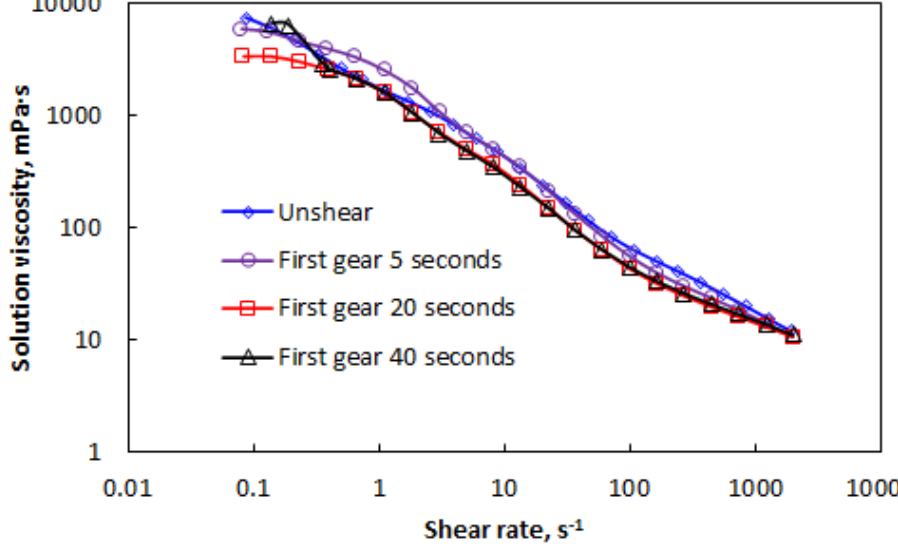
Figure 5. Effect of shear on the rheological curve of AP-P4 with a concentration of 2000 mg/L